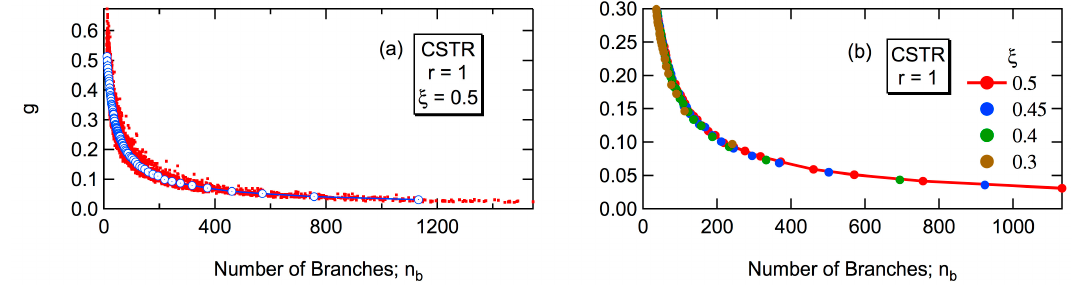
Figure 21. Relationship between the g -ratio and the number n b of branch points in a polymer for a CSTR with r = 1. ( a ) Each data point (red) and the expected g -value (blue), at ξ = 0.5. ( b ) The expected g -ratio for ξ = 0.5, 0.45, 0.4, and 0.3.